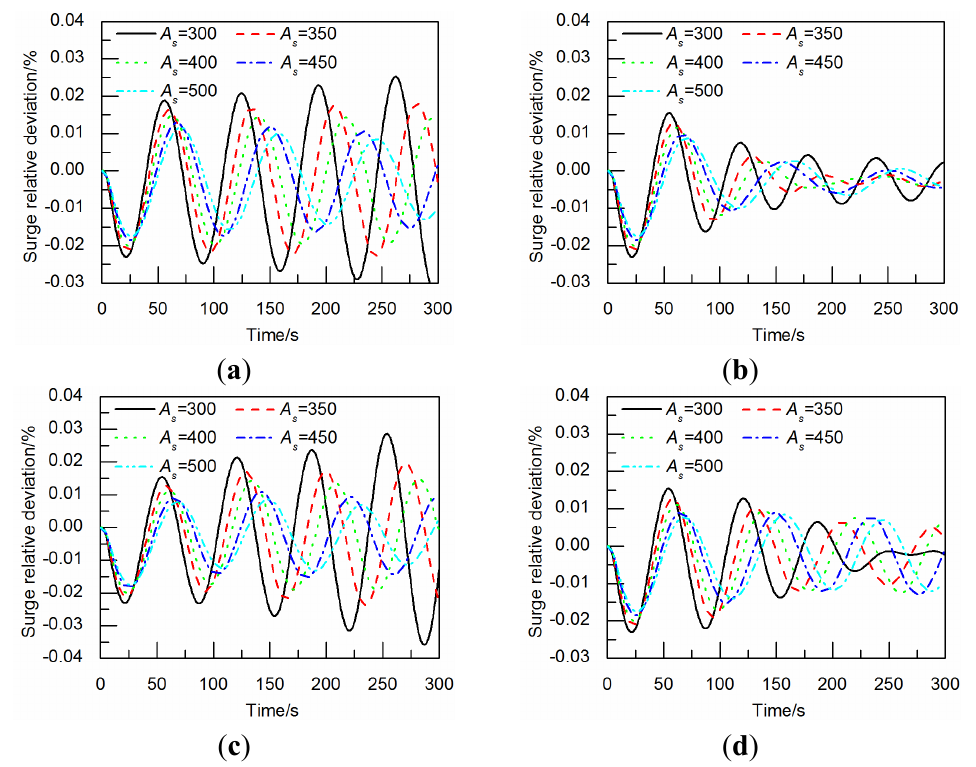
Figure 11. The influence of surge tank area on the regulation quality: ( a ) L = 100 m;